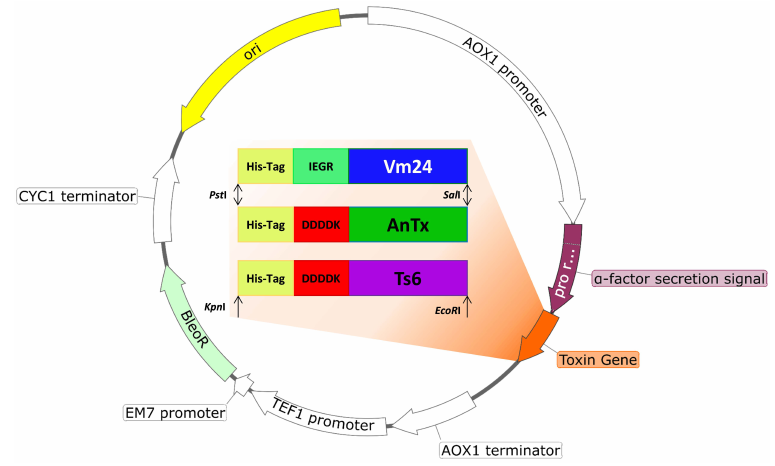
Figure 1. Graphical representation of recombinant plasmid pPICZαA -Vm24, -AnTx, and -Ts6.